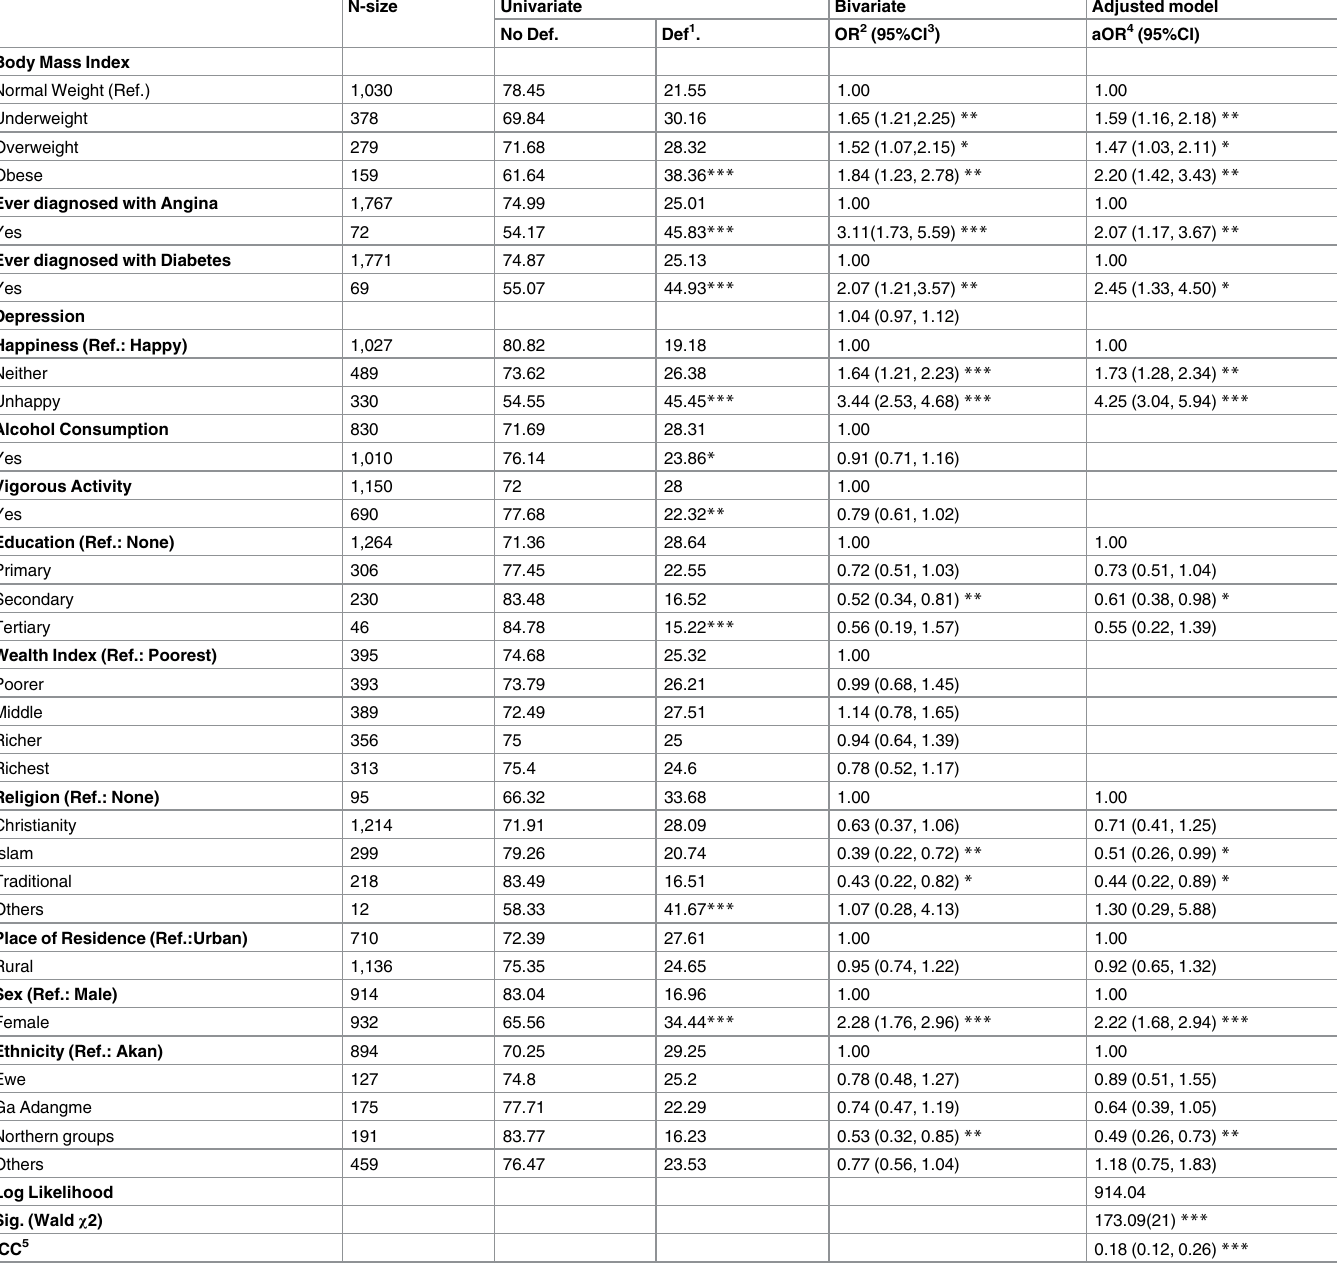
Table 7. Univariate, bivariate and adjusted results of generalized linear mixed effect logit model of instrumental activities of daily living (IADLs) on elderly obesity. N-size Univariate Bivariate Adjusted model No Def. Def 1 . OR 2 (95%CI 3 ) aOR 4 (95%CI) Body MassIndex